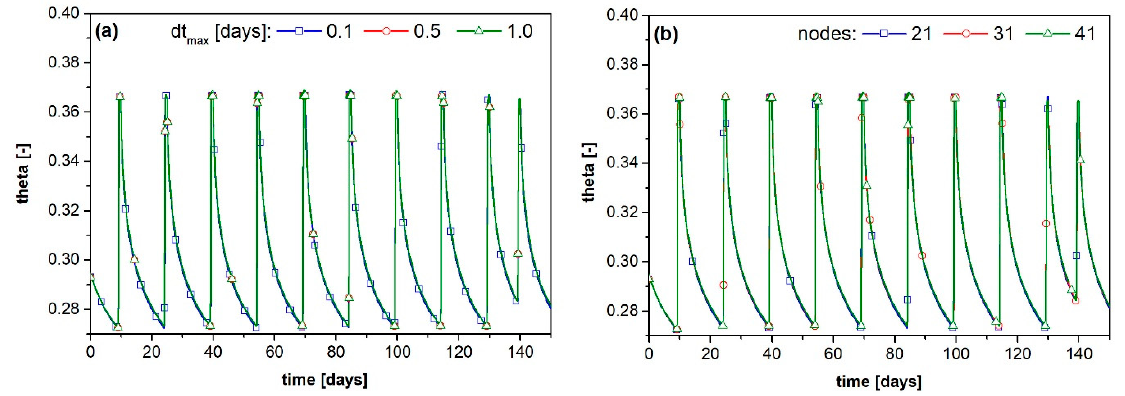
Figure 3. Soil moisture variation, theta, for ( a ) different time steps (using 21 nodes), and ( b ) different finite element nodes (using dt max = 1 day). finite element nodes (using dt max = 1